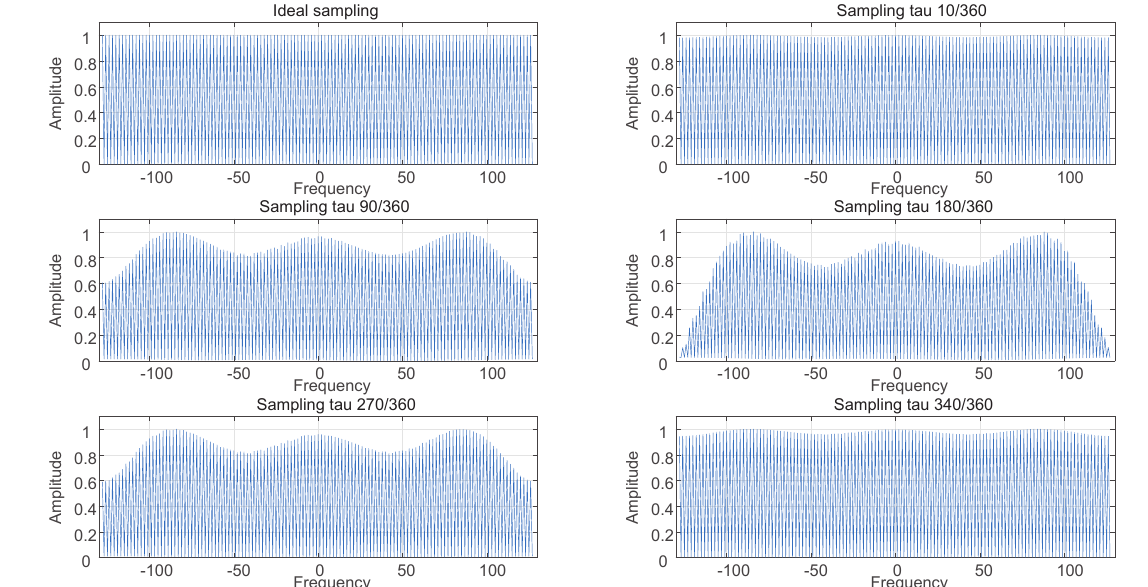
Figure 7. Frequency domain analysis of sequences in different τ s . Since the output is not a linear function of f , different frequencies exhibit different degrees of attenuation. By comparing different sampling phases in Figure 7: Some fre- quency bands have almost no attenuation, but some frequency bands directly attenuate to a lower value when the phase shift is large. The attenuation curves of different fre- quencies at different phases are shown in Figure 8. The relationship of each frequency is: f 1 < f 2 < f 3 < f 4 < f 5 < f 6 < f 7.